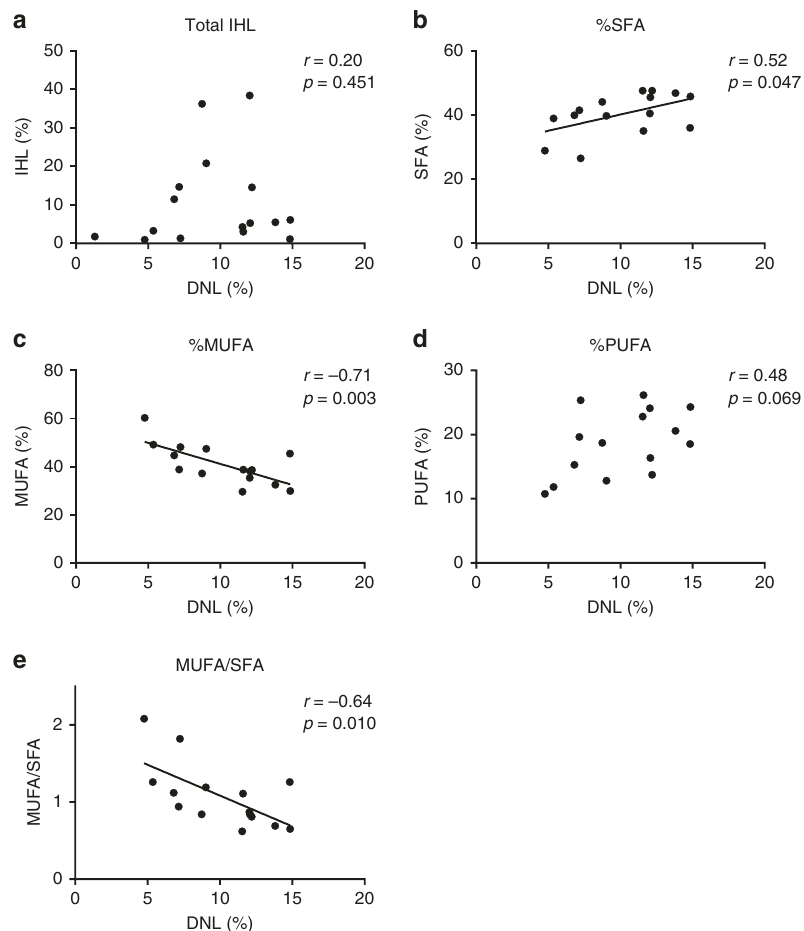
Fig. 5 Relationship between DNL and liver fat composition. The relationships between DNL and a total liver fat content, b SFA fraction, c MUFA fraction, d PUFA fraction, and e MUFA/SFA ratio in healthy overweight/obese participants (with and without NAFL, n = 16 for total liver fat content and n = 15 for the fatty acid fractions and MUFA/SFA ratio). The correlation coef fi cient is shown in the respective plots ( a ; two-sided Spearman correlation, b – e ; two- sided Pearson